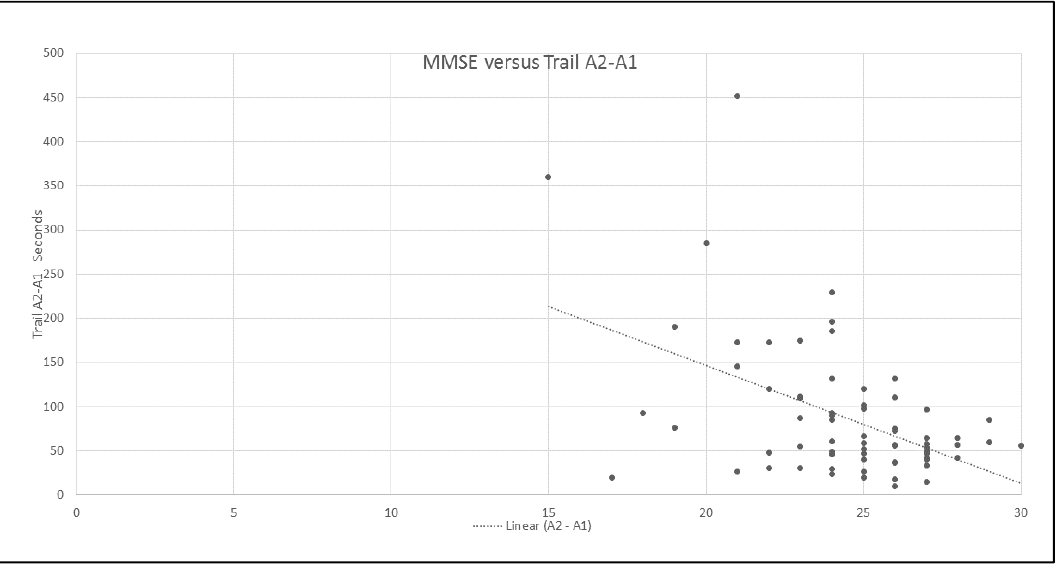
Figure 2. The difference scores in the Memory Quotient after treatment. Note: ** indicates the statistical significance between within groups comparison for p < 0.05.